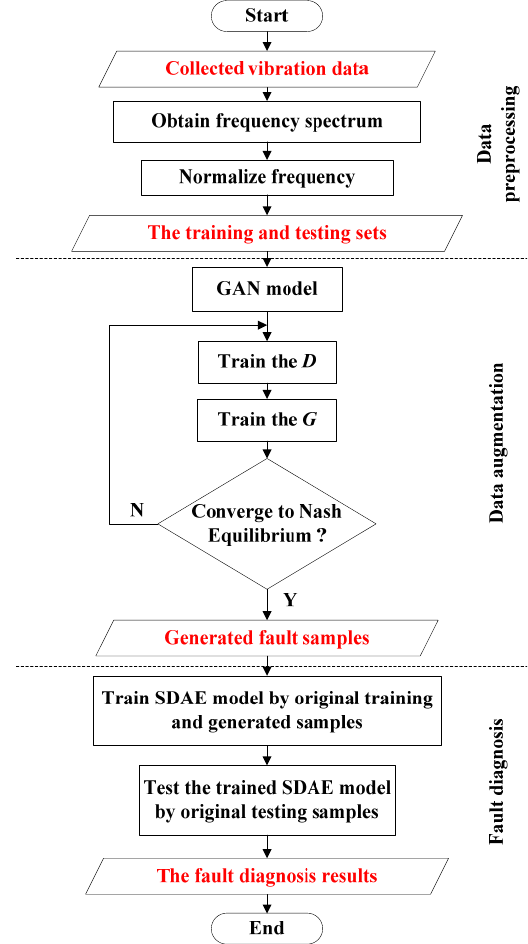
Figure 11. Flow chart of the GAN ‐ SDAE system for fault diagnosis.